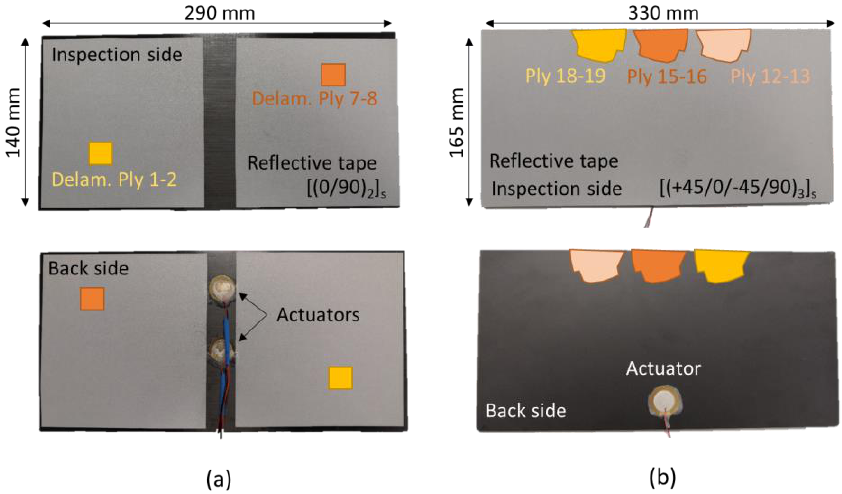
Figure 1. Schematic overview of all steps in the damage detection procedure.